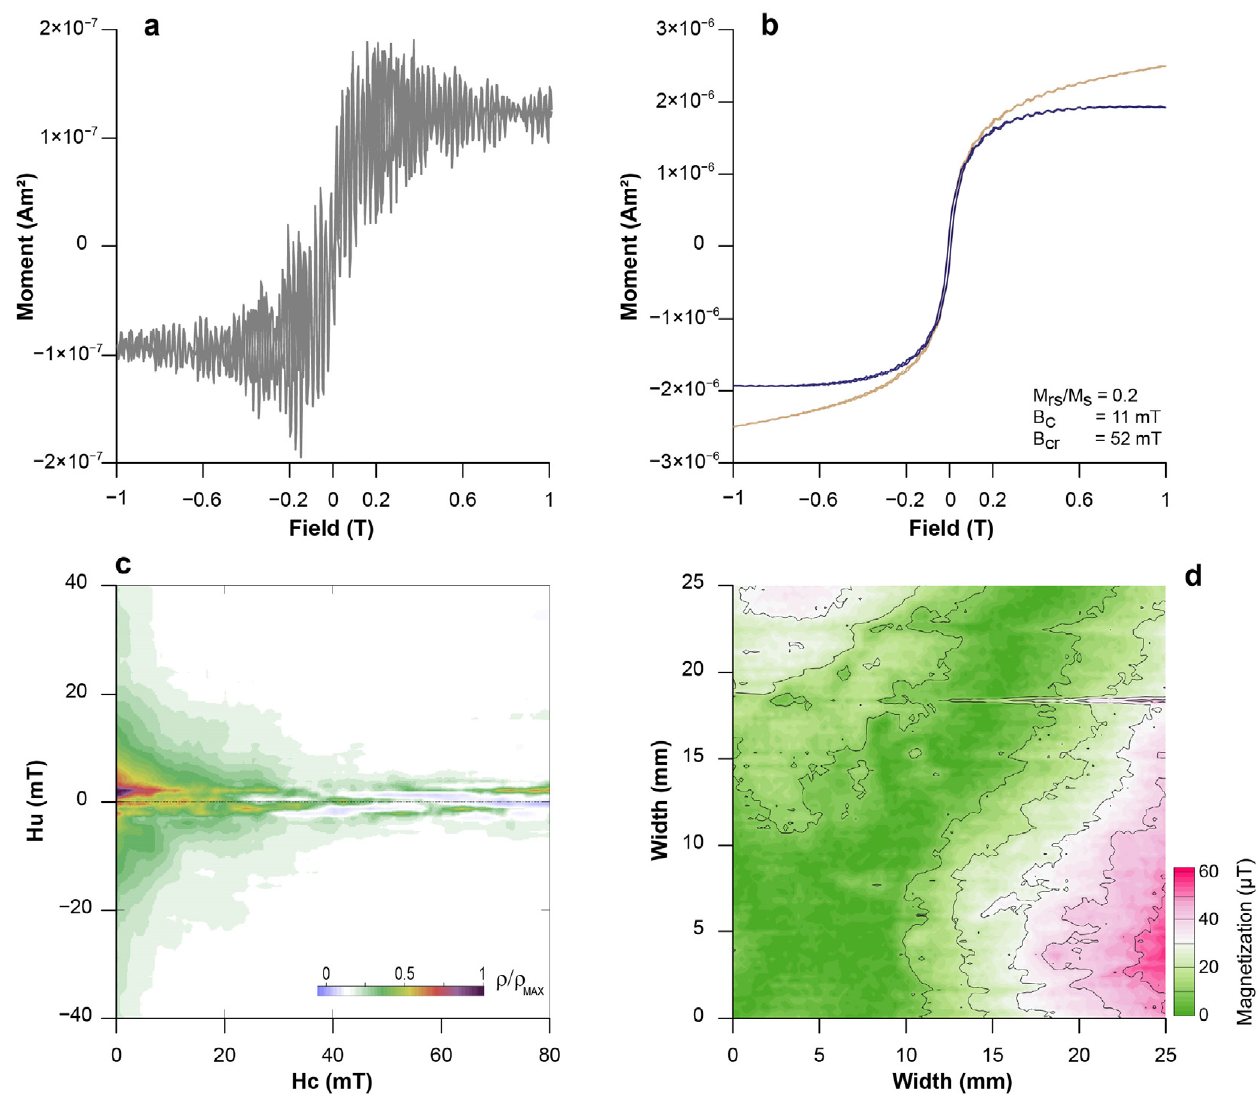
Figure 5. Magnetic properties of biogenic reefs in core XK-1. ( a ) Hysteresis loops at 1256 m. ( b ) Hysteresis loops at 1239 m. ( c ) FORC diagram at 1239 m with a smoothing factor of 9. ( d ) Scanning result of the sample at 1239 m with a 200- µ m interval. Note that hysteresis loop measurements were taken of 11 samples in total, and, since the other 9 samples had a similar loop with ( a ), these loops are not shown in the figure.